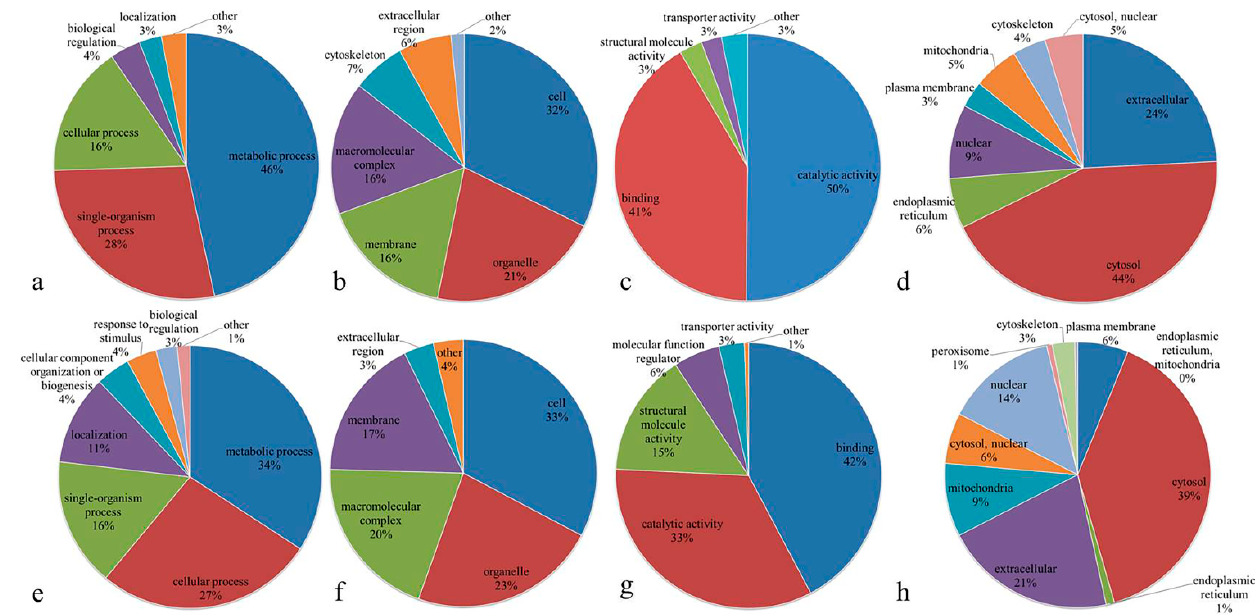
Figure 6. Pie charts indicating the Gene Ontology (GO) functional classification of the DEPs in IADN/COSMN group: ( a ) up-regulated DEPs classified according to biological process; ( b ) up-regulated DEPs classified according to cellular component; ( c ) up-regulated DEPs classified according to molecular function; ( d ) subcellular localization of up-regulated DEPs; ( e ) down-regulated DEPs classified according to biological process; ( f ) down-regulated DEPs classified according to cellular component; ( g ) down-regulated DEPs classified according to molecular function; ( h ) subcellular localization of down-regulated DEPs.